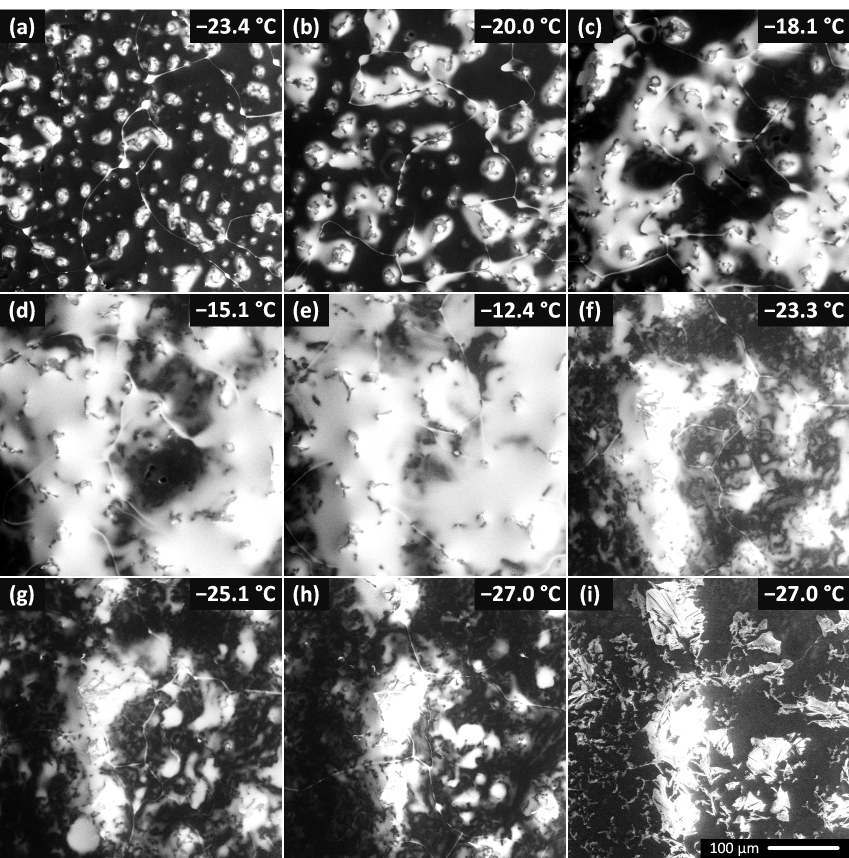
Figure 3. The brine surface coverage as a function of temperature for the seeded 0.005M sample. The temperature was first increased stepwise from − 23 . 4 to − 12 . 4 ◦ C and then decreased to − 27 ◦ C. The corresponding numerical values of the brine surface coverage are given in Fig. 4. A movie from this experiment is included in the Supplement (Movie S1). Panels (h) and (i) display the salt crystals forming from the brine. The crystals formed along the grain boundaries and on the humps where the brine had accumulated previously. The crystallization started a minute after the cooling stage temperature had been set to − 27 ◦ C. The air pressure in the microscope chamber was 500Pa during the sequence. The scale in panel (i) is valid for all the